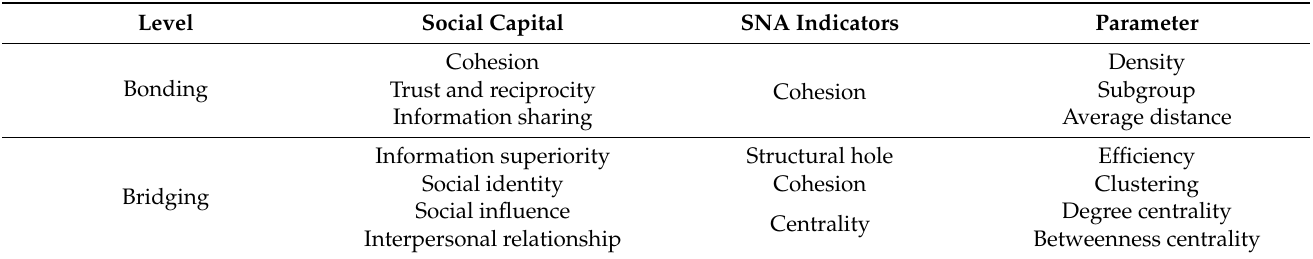
Table 2. Calculation system of Resilience Social Capital for construction projects based on